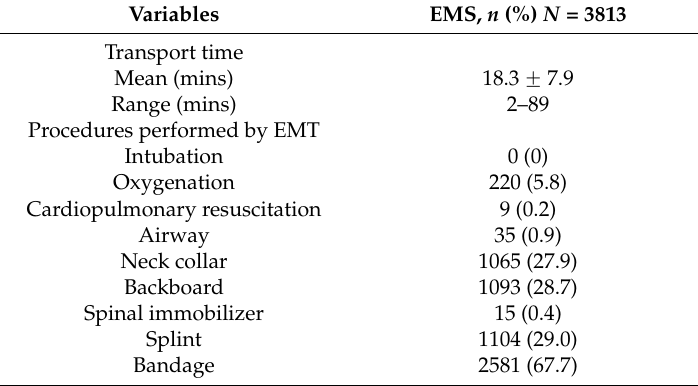
Table 2. Transport time and procedures performed by emergency medical technicians